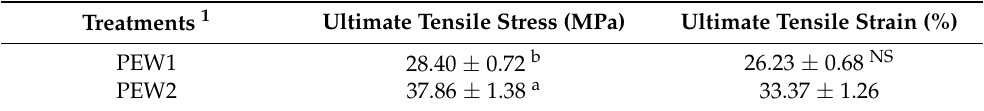
Table 1. Mechanical properties of biodegradable containers made from pork skin gelatin, walnut shells, and